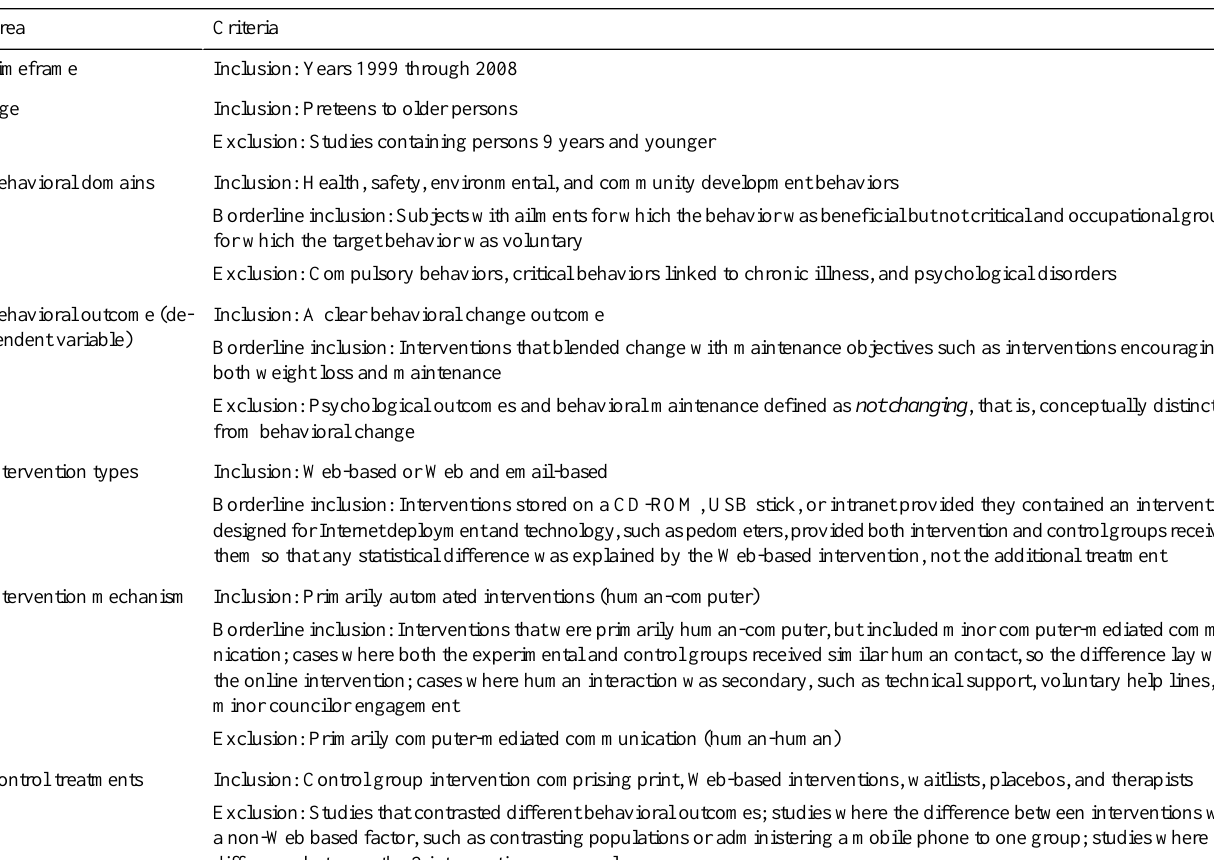
Table 1. Inclusion and exclusion criteria CriteriaArea